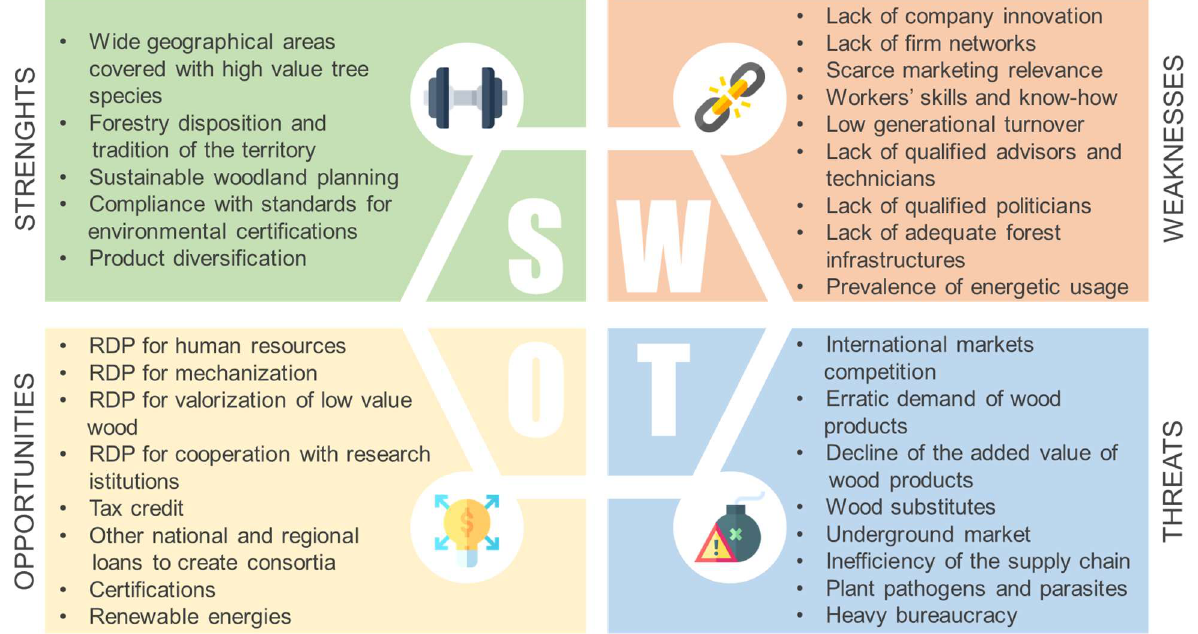
Figure 5. Summary of the SWOT analysis. Notes: RDP = Regional Development Plan; Icons are courtesy of Freepik: https://www.flaticon.com/authors/freepik (accessed 10 November 2022).